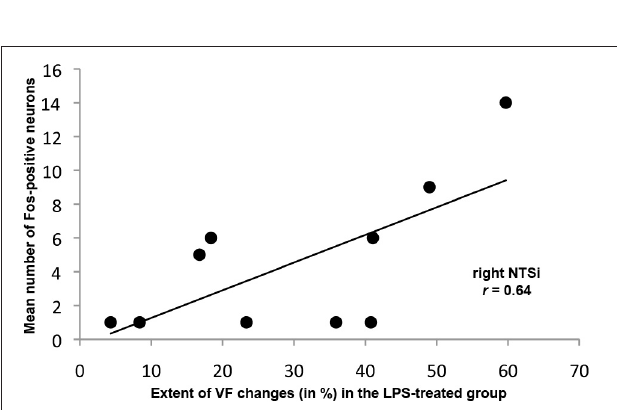
FIGURE 4 | Significant positive relationship between the mean number of Fos-positive neurons in the right NTSi and the extent of VF changes (in %) following LPS-induced inflammation and